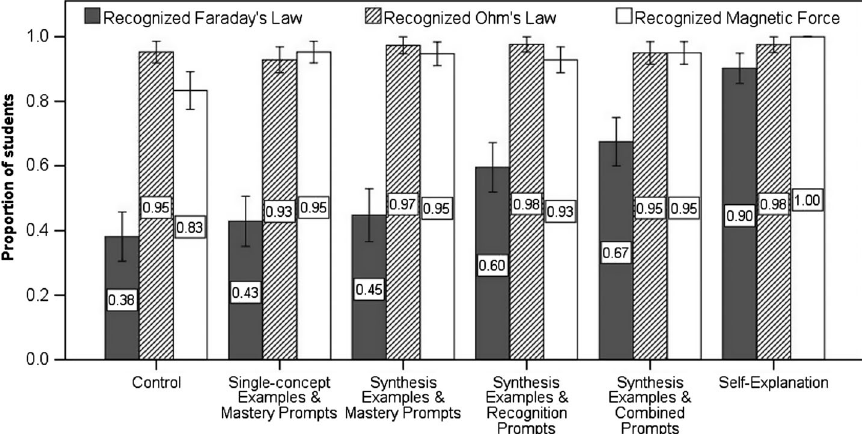
FIG. 6. Proportion of students in each condition demonstrating recognition of Faraday ’ s law, Ohm ’ s law, and magnetic force on the target synthesis problem. Error bars are standard errors.